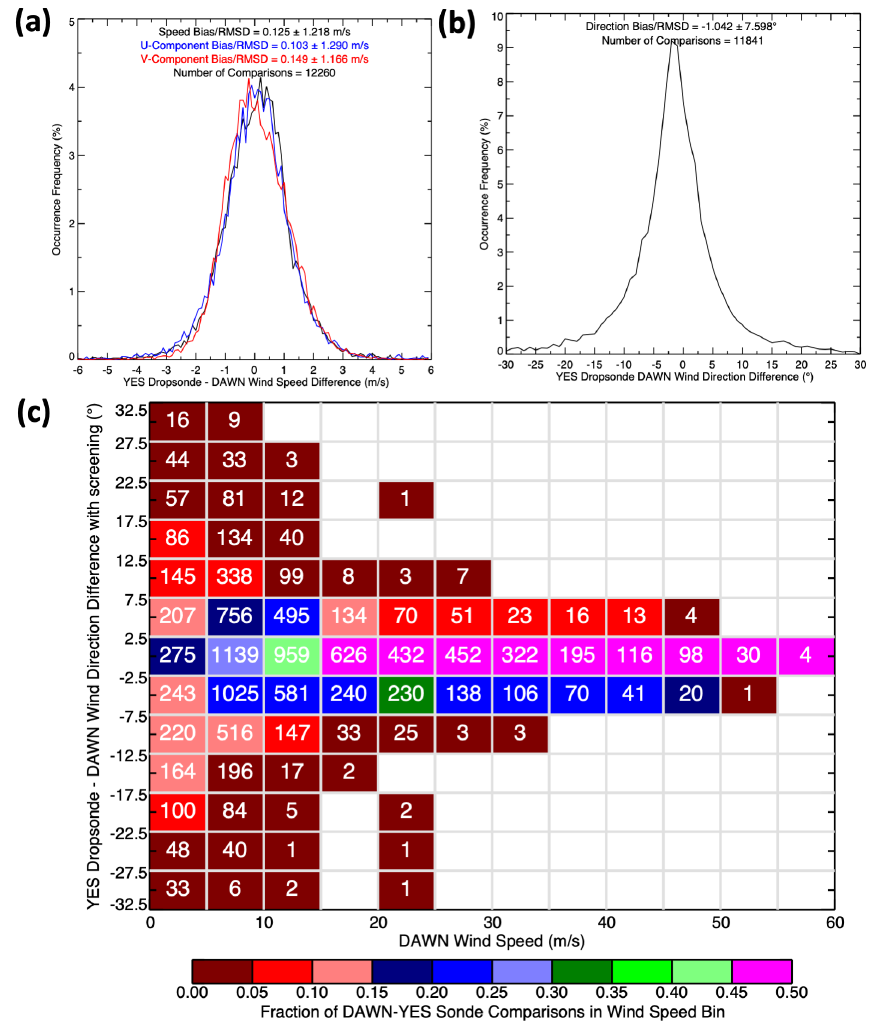
Figure 15. A comparison of DAWN and dropsonde vector wind speed (black), and u - and v -component speed (blue and red, respectively) a ) and direction (b) aggregated across all vertical bins with a valid DAWN retrieval, using the methods described in Sect. 2.3. (c) DAWN-sonde wind direction difference as a function of wind speed, clustered into 5 ◦ and 5ms − 1 bins. Bins are colored by the fraction of observations within a bin relative to the total samples in each column. The number of samples is listed within each